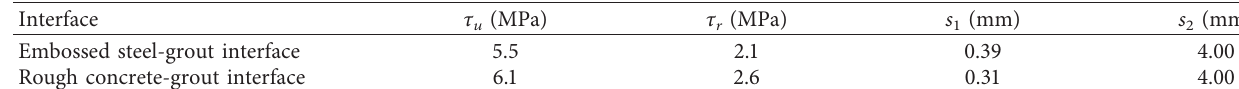
Figure 18: Constitutive laws of interfaces: (a) basic law; (b) steel-grout interface; and (c) concrete-grout interface. Table 4: Parameters in constitutive laws of two interfaces.